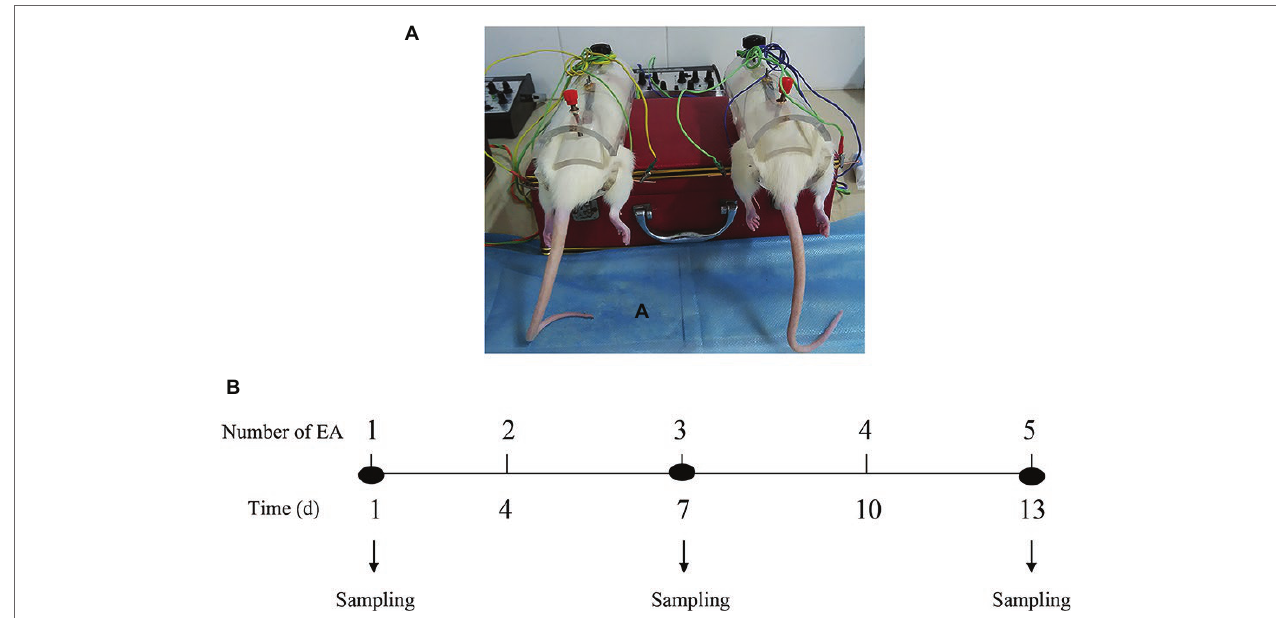
FIGURE 1 | The schematic structure for EA application. (A) The diagrams show the dorsal view of the “Zusanli” and “Sanyinjiao” acupoints we used and the electroacupunture procedures in female rats. (B) The EA treatment was performed on female rats at day 1, 4, 7, 10, and 13. The tissues were acquired at day 1, 7, and 13 after 30 min of each EA